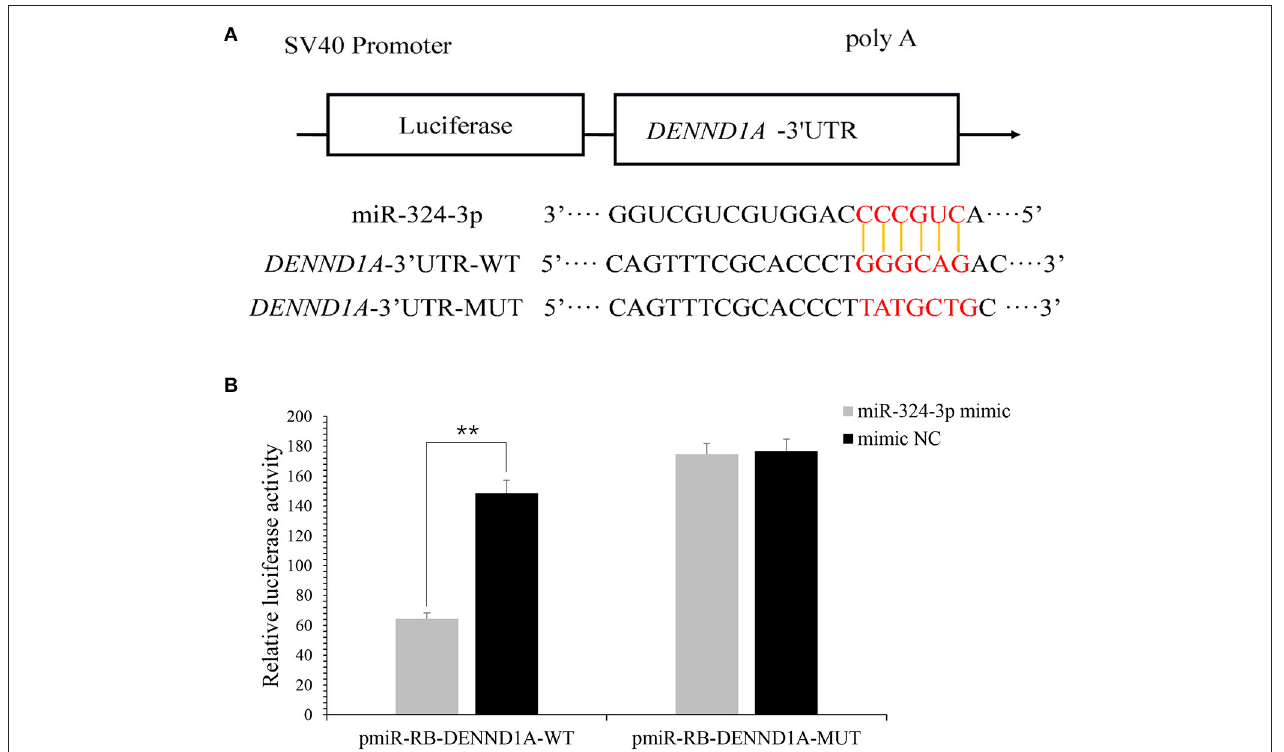
FIGURE 4 | DENND1A is directly targeted by chi-miR-324-3p. (A) Predicted binding sites of chi-miR-324-3p in the 3’-UTR of DENND1A . The red section is the seed region of chi-miR-324-3p. (B) Relative luciferase activities of 293T cells cotransfected with the DENND1A 3’-UTR wild-type and mutant dual-luciferase reporter and chi-miR-324-3p mimic and mimic NC at 48h. UTR, untranslated region. ** P < 0.01.